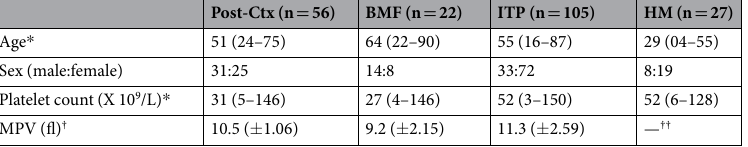
Table 1. Patient characteristics. Post-Ctx: post-chemotherapy BMF: bone marrow failure; ITP: immune thrombocytopenia; HM: hereditary macrothrombocytopenia; MPV: mean platelet volume; * median (min- max); † mean ( ± standard deviation); †† MPV was not measured in 20/27 of the HM patients.